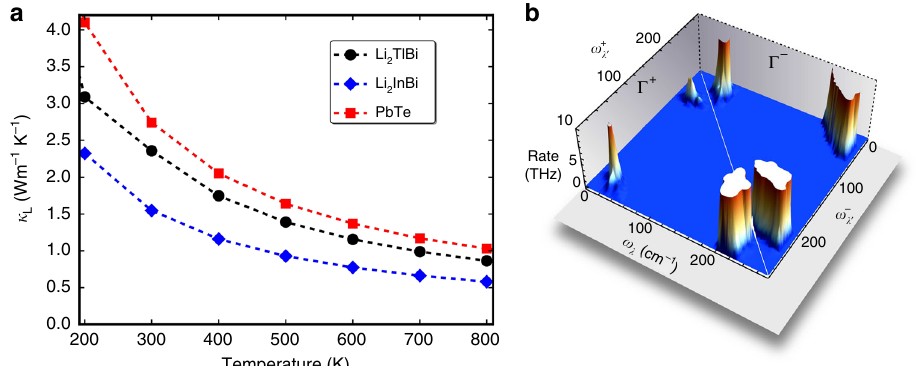
Fig. 7 Phonon transport properties. a Calculated lattice thermal conductivity κ L of Li 2 TlBi, Li 2 InBi, and PbTe as function of temperature. b Phonon scattering rates of Li 2 TlBi in absorption ( Γ + : λ + λ ′ → λ ″ ) and emission ( Γ − : λ ″ → λ + λ ′ )